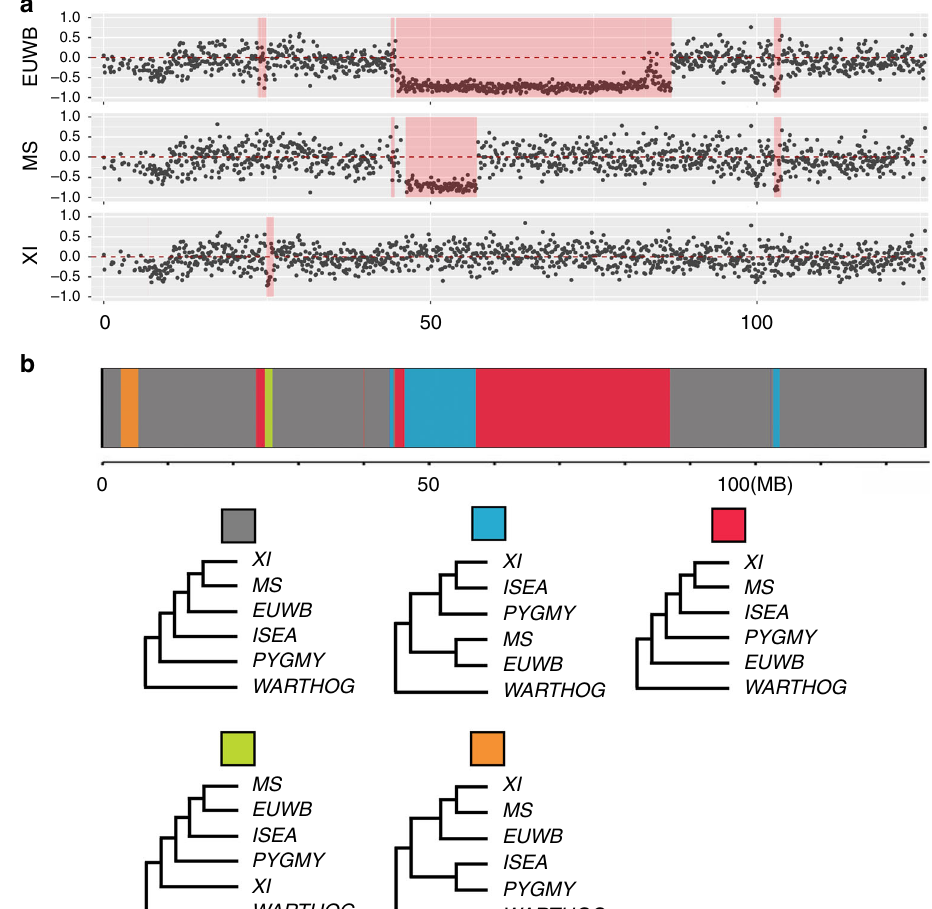
Fig. 3 Genealogical discordance in Chromosome X. a The D-statistic for testing introgression for 100-kb windows on chromosome X for tree topology (((ISEA, X), pygmy hog), warthog) (X = EUWB, MS, and XI). Excesses of BABA in 46 – 86 Mb indicated higher genetic similarity between ISEA and pygmy hog. See supplementary Figs. 9 – 14 for D-statistic testing introgression for 100-kb windows on autosome chromosomes. b SAGUARO plot illustrating the distribution of the fi ve frequent rooted local topologies over the X chromosome. The red unrooted topologies support introgression from a missing linage into European/North China wild boar. Note that the blue unrooted topology includes the discrepant haplotype within Chinese population (see text for further explanation). ISEA = Islands of Southeast Asia Sus; MS = Meishan; XI = Xiang; EUWB = European wild boar; See Supplementary data 3 for further details and supplementary Figure 8 for results for autosomal